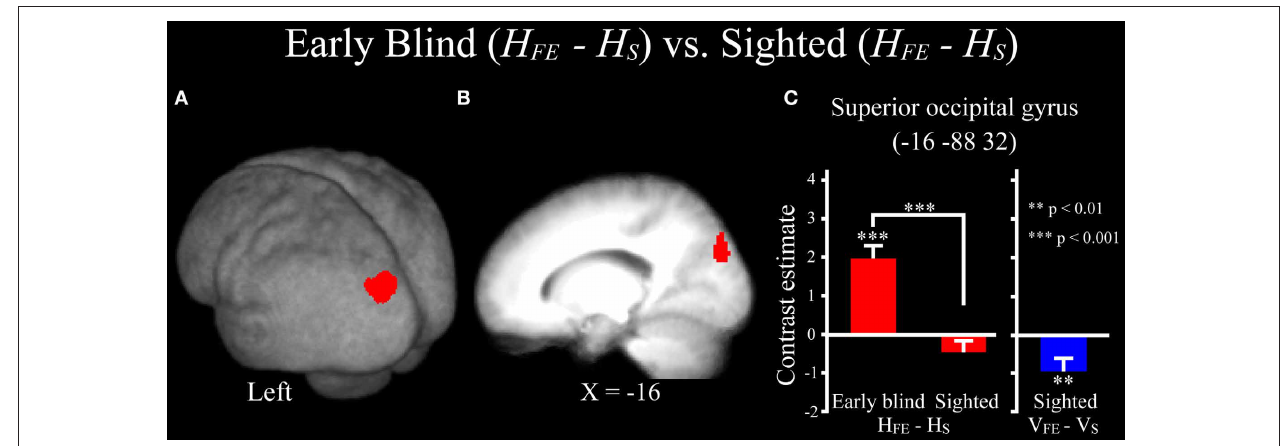
FIGURE 8 | Brain regions more strongly activated by the haptic subjects. (B) The activation pattern was superimposed on the sagittal identification of facial expressions relative to shoes ( H FE − H S ) for section. (C) The bar graphs indicate the activity (contrast estimates) for the early blind compared with the sighted group. This contrast was identification of facial expressions relative to shoes using a volume of evaluated within the brain regions activated by H FE − H S in the early interest with an 8-mm diameter sphere. Asterisks above the error bars blind group. The size of activation was thresholded at P < 0 . 05, indicate the results of the one-sample t -test on the contrast estimates, corrected for multiple comparisons, when the height threshold was set whereas asterisks between the error bars indicate the results of the at Z > 2 . 58. (A) The activation patterns were superimposed on a independent t -tests. Data are presented as the mean ± SEM of 17 surface-rendered T1-weighted high-resolution MRI averaged across the early blind and 22 sighted subjects. Table 4 | Group comparisons of brain regions activated by haptic identification of facial expressions relative to shoes ( H FE − H S ). Spatial extent test MNI coordinate Z -value Hemisphere Anatomical region Cluster size (mm 3 ) P -values x y z EARLY BLIND VS. SIGHTED CONTROL GROUP 1512 < 0.05 − 16 − 88 32 4 . 08 L Superior occipital gyrus − 28 − 84 40 2 . 66 L Middle occipital gyrus SIGHTED CONTROL VS. EARLY BLIND GROUP 3688